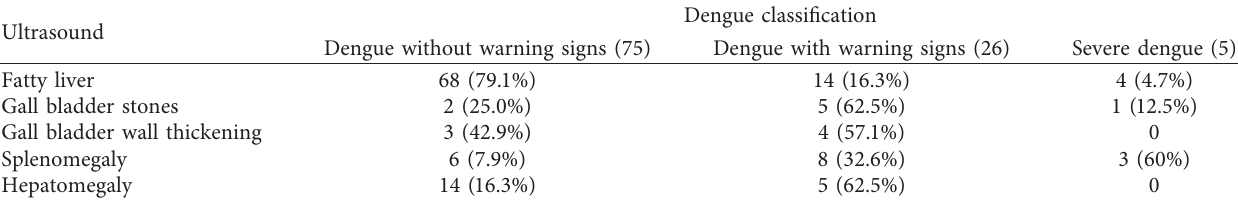
Table 2: Ultrasonography abdomen findings in dengue.